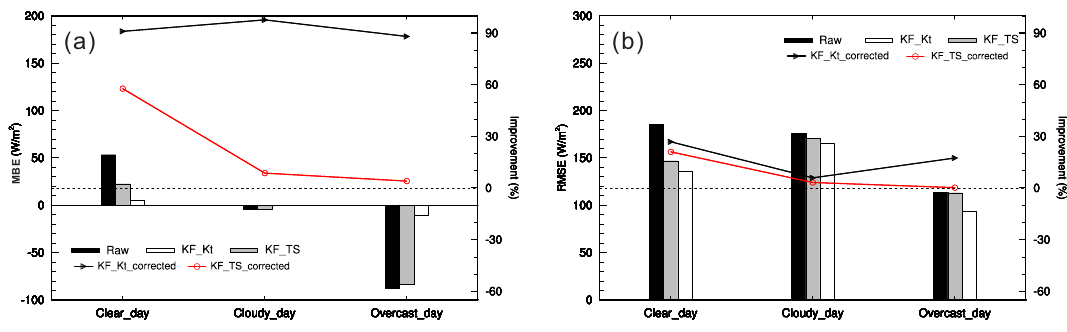
Figure 9. The same as in Figure 8, but for the Qinghai